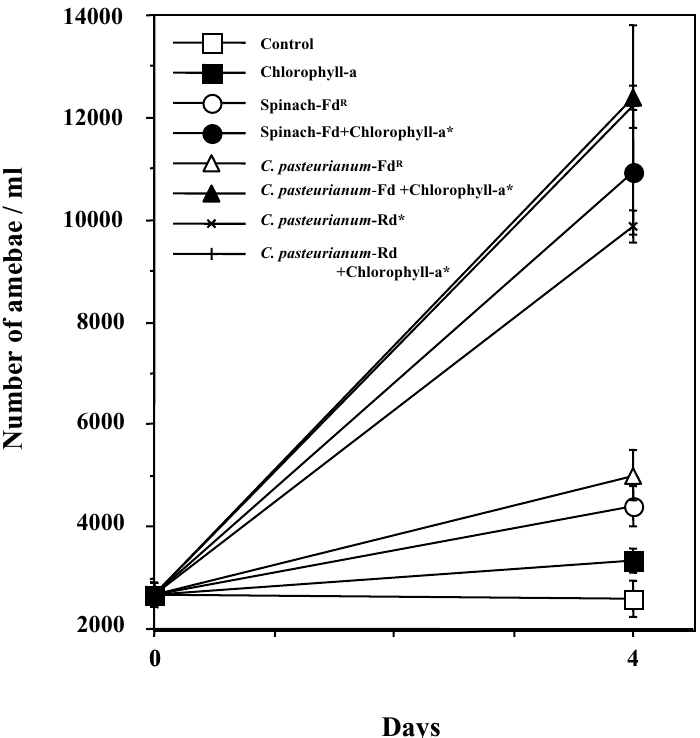
Fig. 6. - Effect of chlorophyll-a ( ), 0.6 % 2ME- treated spinach ferredoxin (Fd) ( ), Clostridium pasteurianum Fd ( ) and C. pasteurianum rubre- doxin (Rd) ( ), and complexes of chlorophyll a with spinach Fd ( ), C. pasteurianum Fd ( ) and C. pasteurianum Rd ( ) on the growth of E. dispar , and control ( ). The growth kinetics of the E. dispar AS 16 IR strain in the YIGADHA-S medium are shown (mean numbers of amoebae in duplicate cultures are plotted). *: the mean of the growth-kinetic level was significantly higher than that of the control (* p < 0.01 by Dunnett’s test). R: the significant difference was retained by Dunnett’s test ( p <